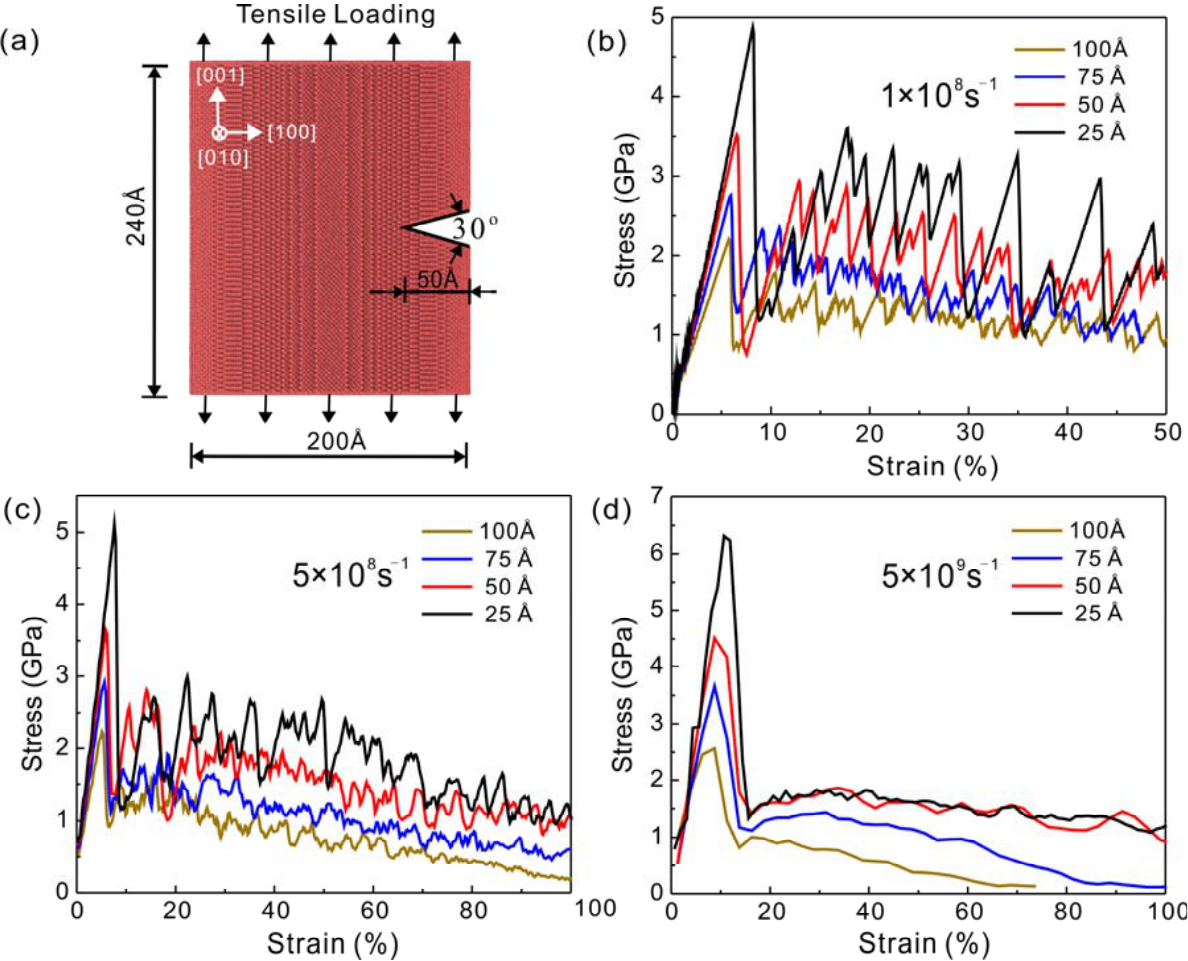
Figure 1. ( a ) Schematic diagram of a Cu nanowire with a 50 Å edge crack. The crack plane is located in the (001) plane, and the leading edge of the crack is along the [010] direction. Stress-strain curves of Cu nanowires with (001) [010] four different depths of edge cracks under type I loading conditions: ( b ) 1 × 10 8 s − 1 , ( c ) 5 × 10 8 s − 1 , ( d ) 5 × 10 9 s − 1